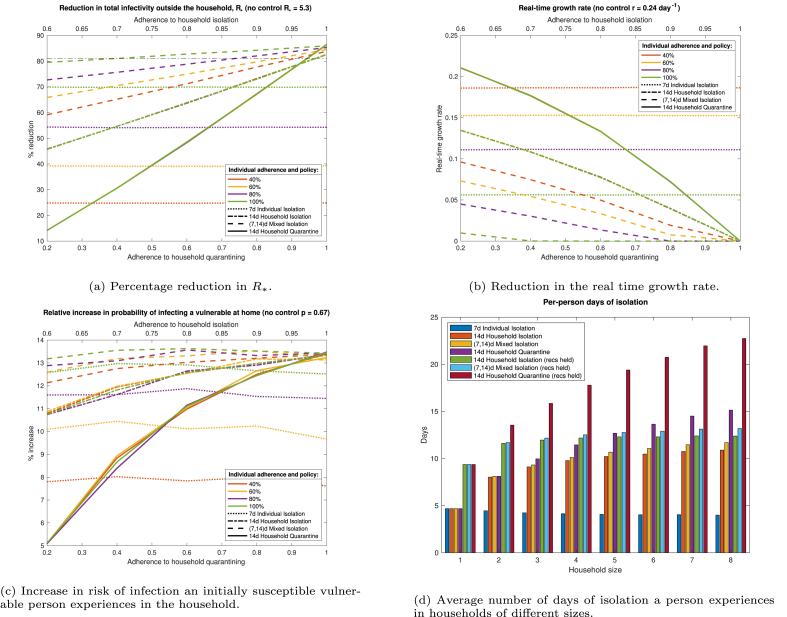
Impact of different control policies and levels of adherence on transmission, infection risk, and time in isolation. (a) Percentage reduction in R∗, defined as the total amount of community transmission spread by an average household early in the epidemic, which equals 5.3 for baseline parameters in the absence of control; (b) real-time growth rate, which is assumed to be 0 (rather than negative) when the infection is controlled; (c) increase in risk of infection an initially susceptible vulnerable person experiences in the household; and (d) the average number of days of isolation a person experiences on average in households of different sizes, computed for each size as the average total person-days in isolation divided by the number of individuals in the household. In (a)–(c), line styles refer to different control policies and colours to different levels of adherence to individual isolation. The lower x-axis gives the adherence to household quarantine, and the upper x-axis adherence to household isolation. We assume that household isolation is less demanding, and therefore adherence is assumed to be ‘‘twice as high’’, meaning it is at the midpoint between that of household quarantine and 1 (e.g. 0.6 for an x value of 0.2, 0.9 for an x value of 0.8, etc.). The black dash-dotted line in (a) gives the amount needed to control the spread by achieving R∗=1. Notice how: the effect of individual isolation is independent of adherence to household quarantine (dotted lines); the effect of household isolation is independent of adherence to individual isolation (overlapping dash-dotted lines); mixed isolation is always superior to household isolation; household quarantine is only optimal at really high levels of adherence (for these baseline parameters, generally, beyond the level needed to achieve control), but quickly becomes suboptimal to mixed isolation as adherence is reduced. When a sufficiently large reduction in R∗ is achieved in (a), the growth rate drops to 0 in (b). The increased risk an initially susceptible vulnerable person is infected at home (c) does not reflect this effect, as it represents the increased risk conditional on an introduction: if the infection were controlled in the community, the overall risk of a vulnerable person getting infected would vanish as the risk of introduction in the household vanishes. For these plots, ne=10000 simulations are performed for each household size. Nevertheless, a large amount of stochastic noise is still visible in (c). In (d), the same control policies are considered, but the household-based ones are considered both in their naïve form (where recovered individuals remain isolated), and in their upgraded version where recovered individuals are free to leave the house: they are identical in terms of transmission but the naïve versions are significantly more costly in terms of person-days of isolation. In a household of size 1 (no within-household transmission), the days in isolation would be exactly 7 or 14 if all cases were symptomatic (here ps=2/3); similarly, in all households, individual isolation would total exactly 7 days if all cases were symptomatic and all individuals in the household were ultimately infected. In (d), we assume that adherence is 100% to each intervention.